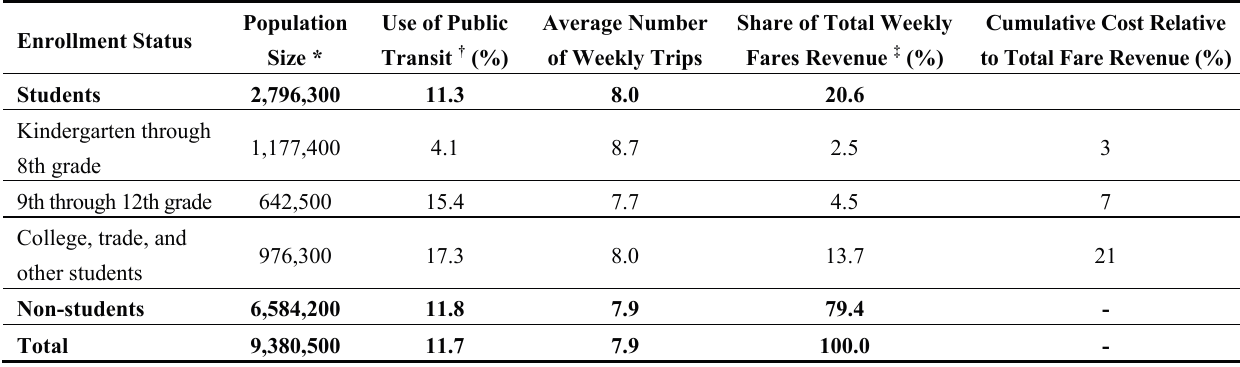
Table 1. Estimates of decreases in public transit fare revenues for Los Angeles County transportation agencies if free transit passes were provided to all